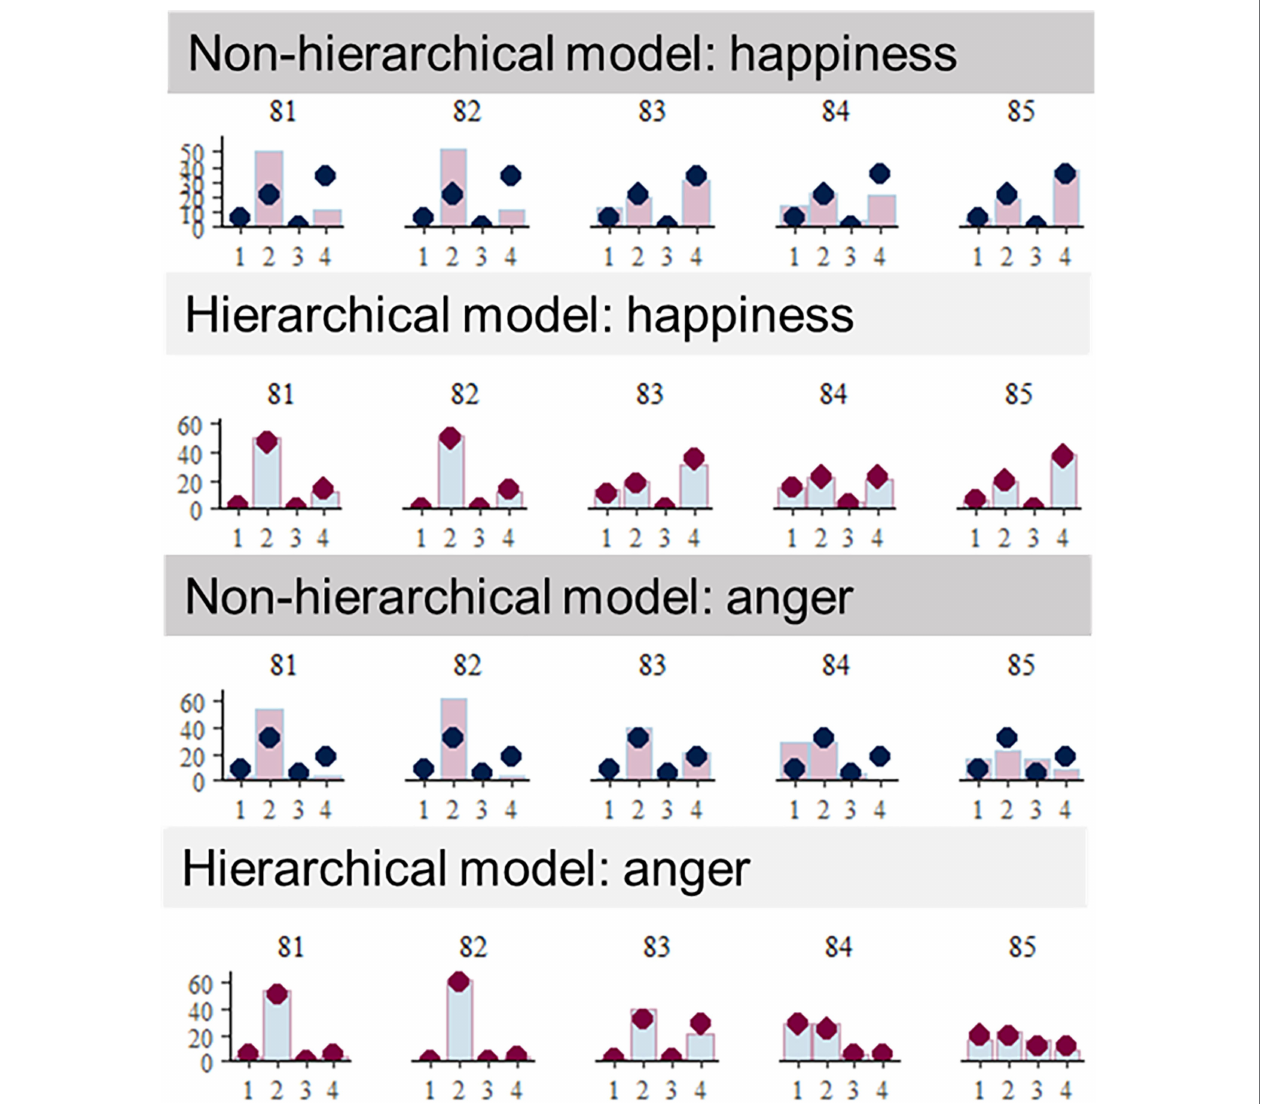
FIGURE 3 | Individual data of Model 3 (non-hierarchical model) and of Model 4 (hierarchical model). For illustration, data of the five participants were selected. The bar signifies observed behavior; the dot denotes the predictive posterior value by the model. Sufficient overlaps between the bars and the dots indicate that the individual observed behaviors were well predicted by the (hierarchical or non-hierarchical) model.